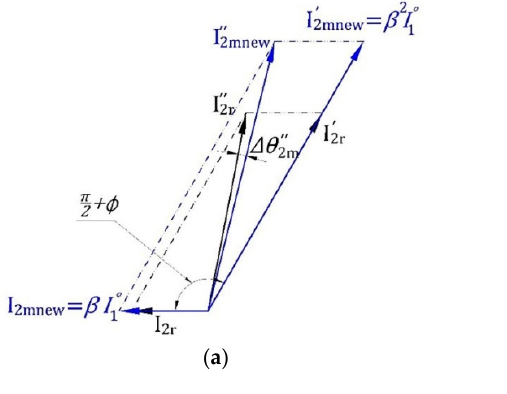
Figure 2. The effect of main sideband current components magnitude variation on their angles variation. ( a ) The effect of right sideband component magnitude variation on ∆ θ 2 . ( b ) The effect of left sideband component magnitude variation on ∆ θ 2 1